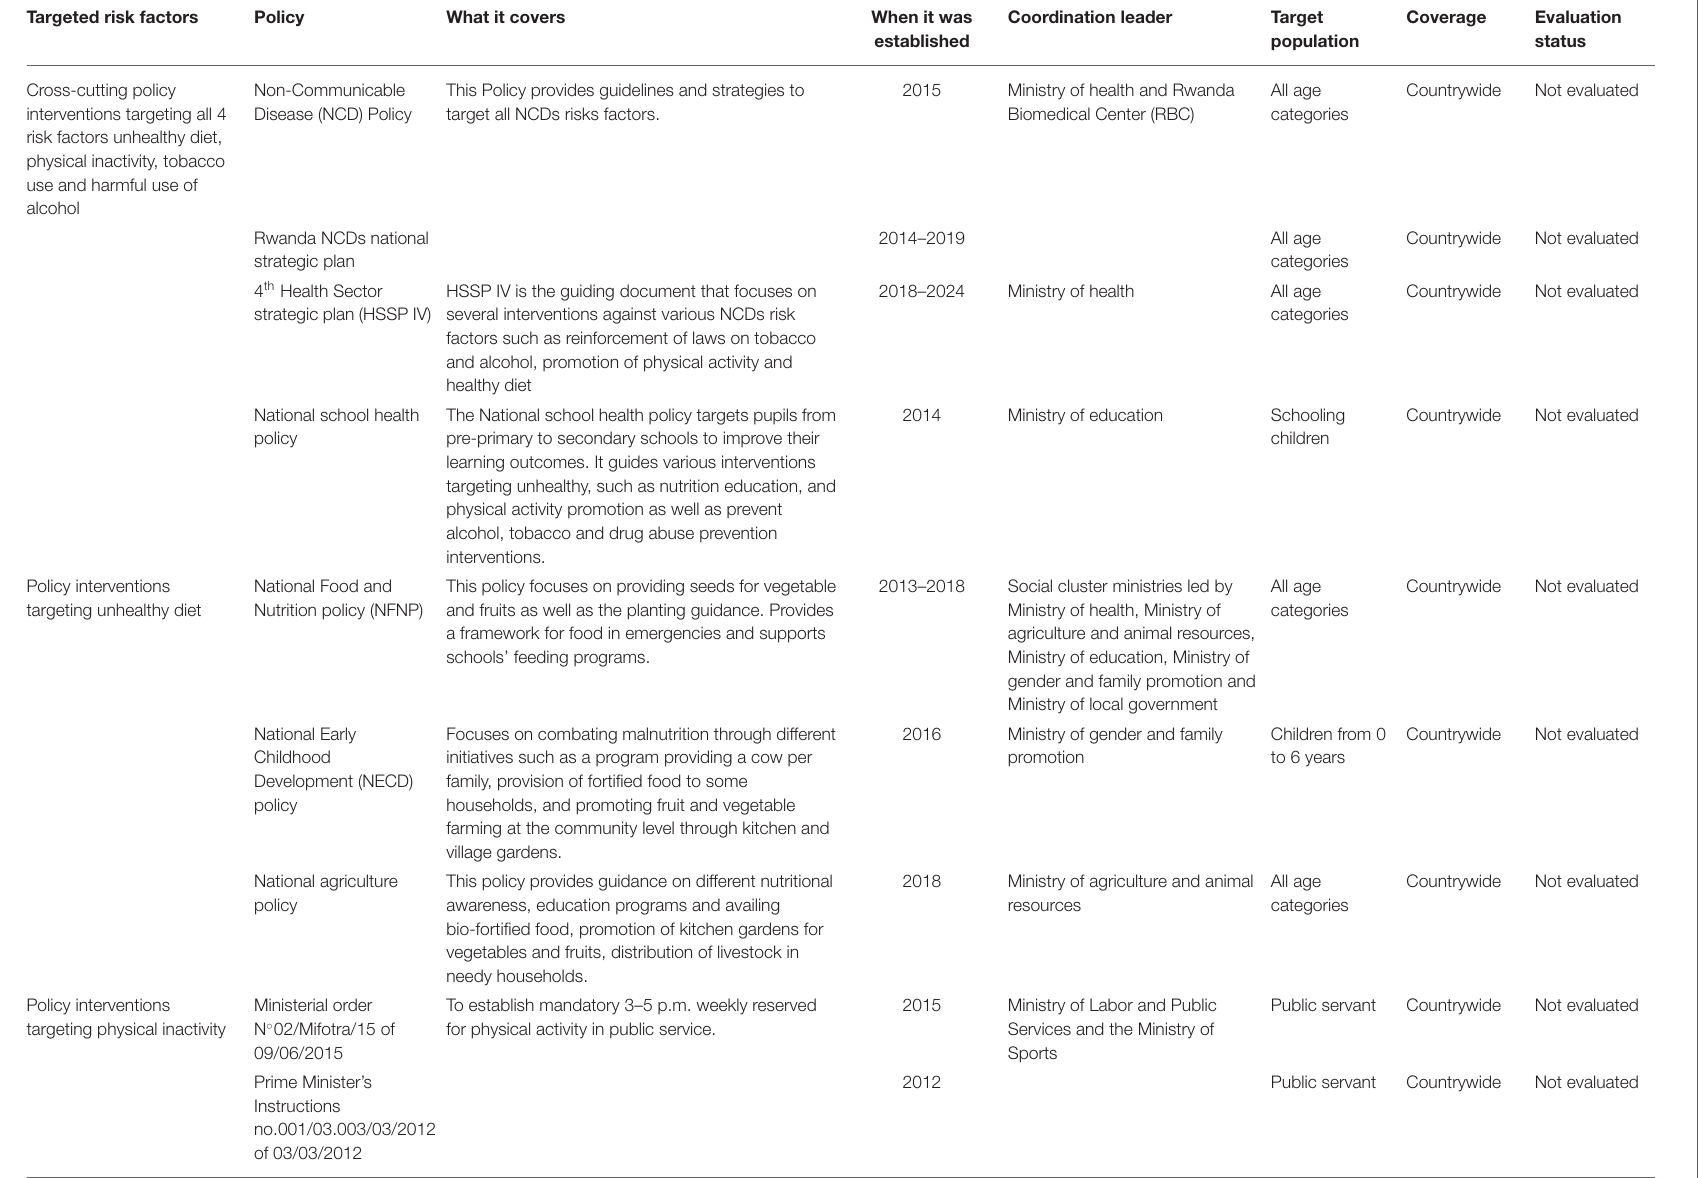
TABLE 2 | Population—level policy interventions targeting risk factors for hypertension and diabetes being implemented in Rwanda. Targeted risk